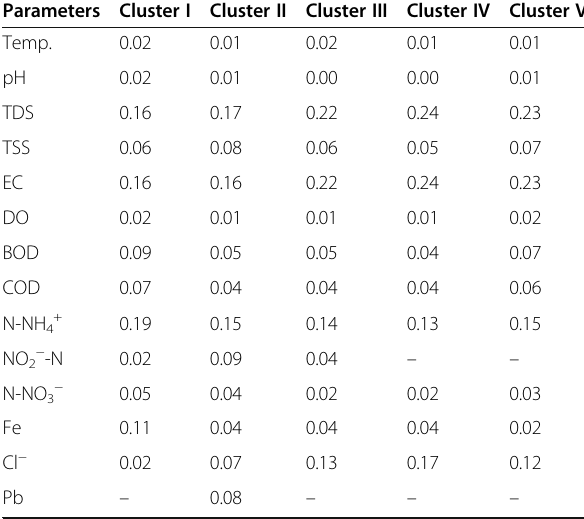
Table 4 Weights of water quality parameters in the identified